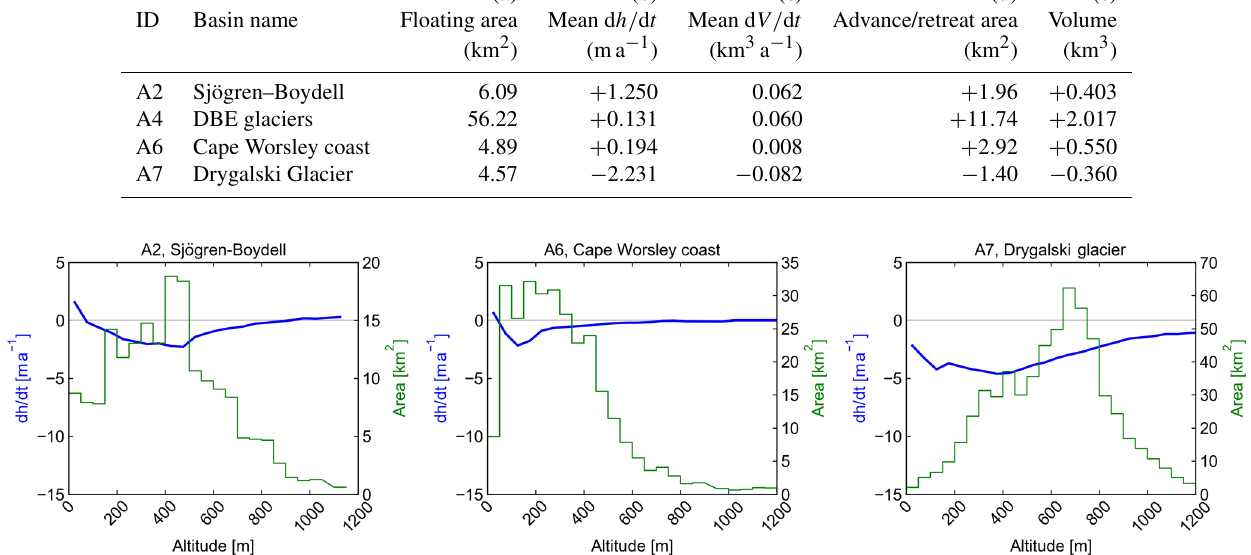
Figure 3. Rate of glacier surface elevation change d h/ d t (in ma − 1 ) from 2013 to 2016 versus altitude in 50m intervals for basins A2, A6 and A7. Green line: hypsometry of surveyed glacier area inkm 2